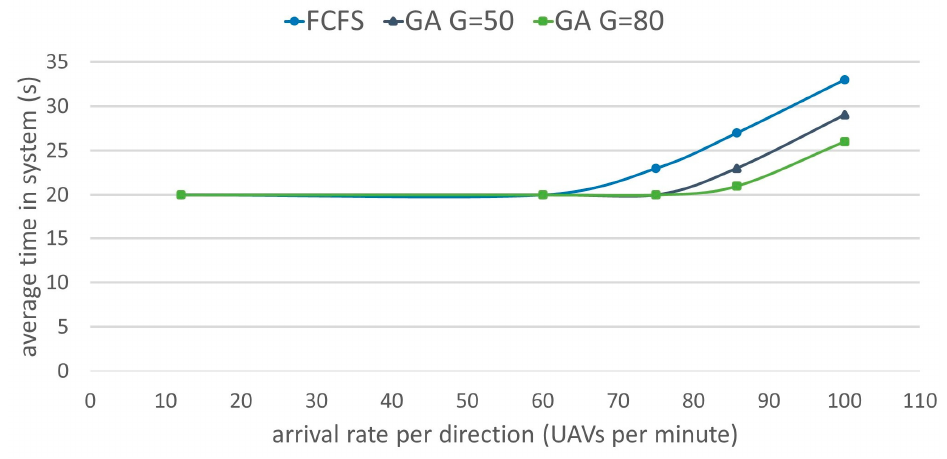
Figure 19. UAVs’ average time in the system using our proposed system and using FCFS schedul- ing.